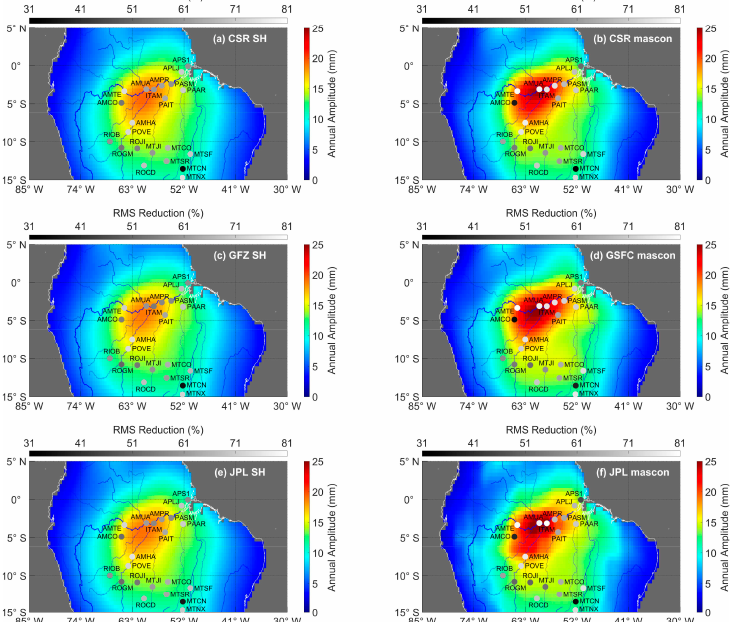
Figure 5. The RMS reductions after removing GRACE/GRACE-FO derived displacements from the GNSS heights at the 22 selected stations, using different products: ( a ) CSR SH, ( b ) GFZ SH, ( c ) JPL SH, ( d ) CSR mascon, ( e ) GSFC mascon, and ( f ) JPL mascon. The gray scales of the round dots represent the values of RMS reductions. The background colors denote the same as in Figure